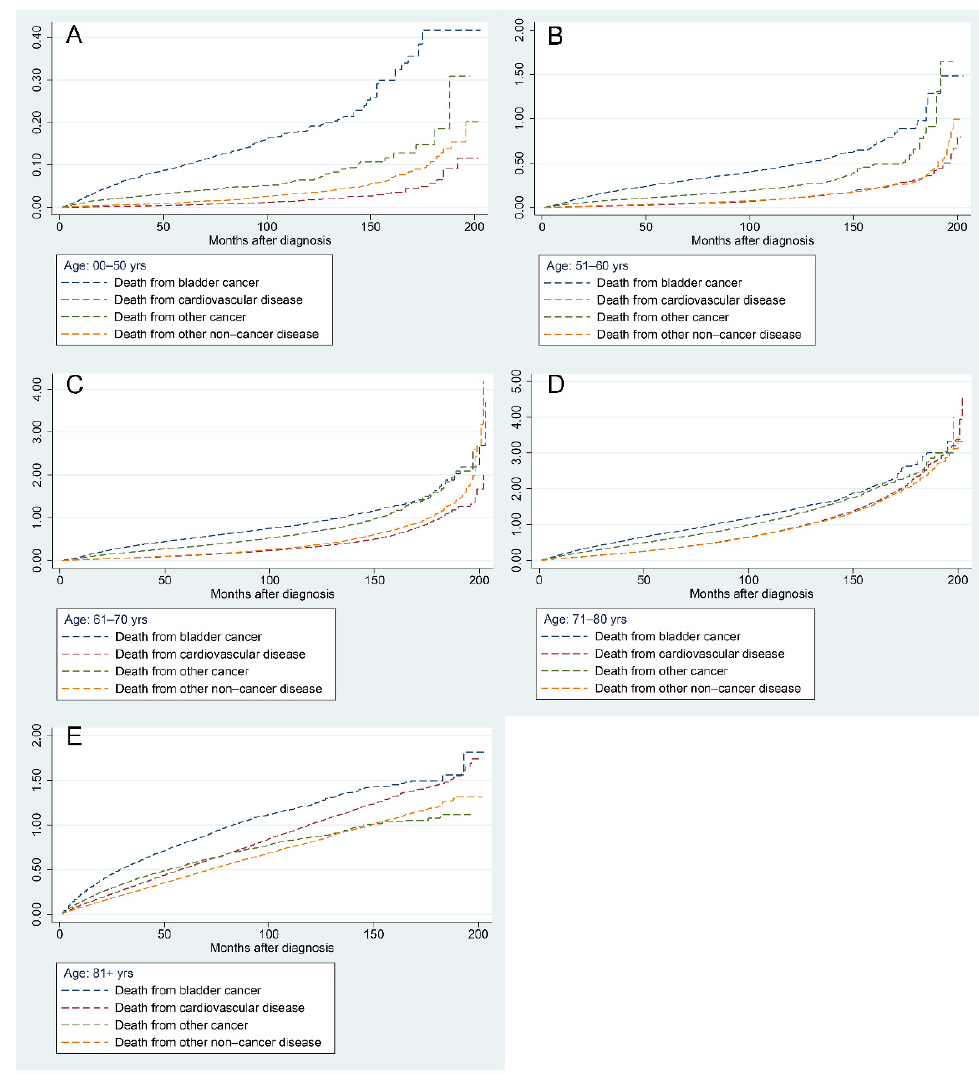
Figure 7. Nelson–Aalen cumulative hazard curves for all causes of death in primary bladder cancer patients in different age groups: 0–50 years ( A ), 51–60 years ( B ), 61–70 years ( C ), 71–80 years ( D ), and 81+ years ( E ).